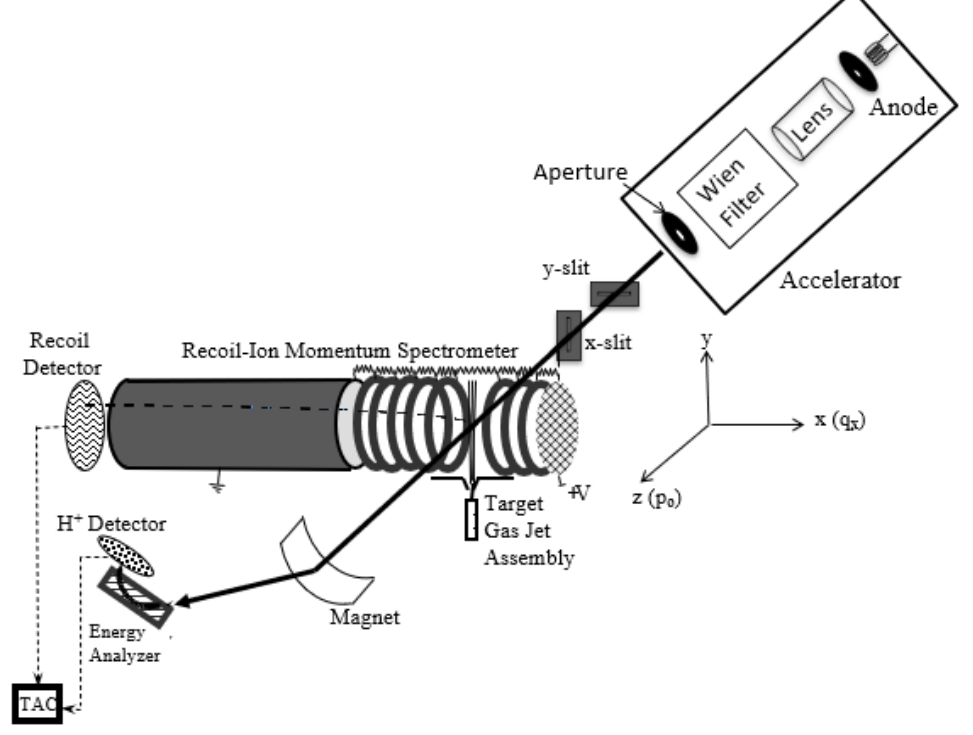
Figure 1. Schematic sketch of the experimental set-up.